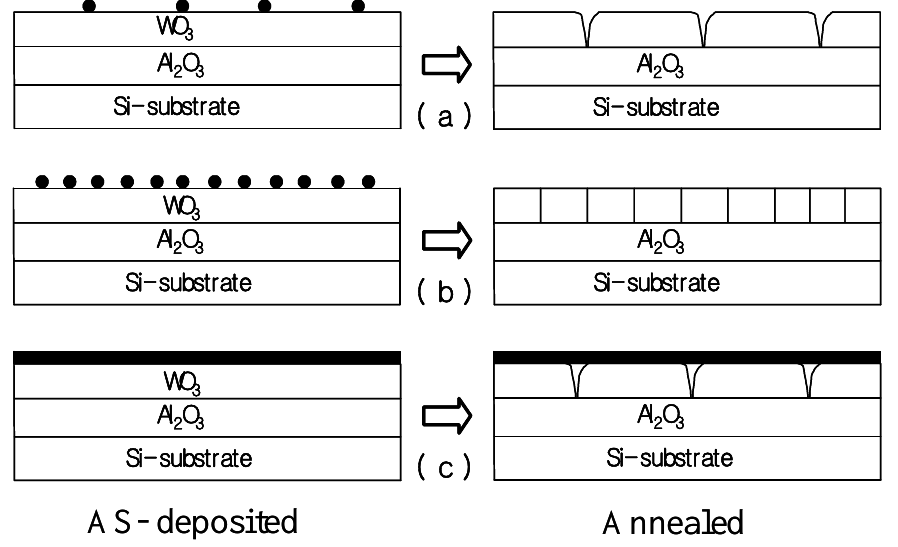
Figure 9. Mechanism of the crack formation and suppression in NiO deposited WO (a) less (b) optimum (c) excess of NiO. Black dots and layers represent